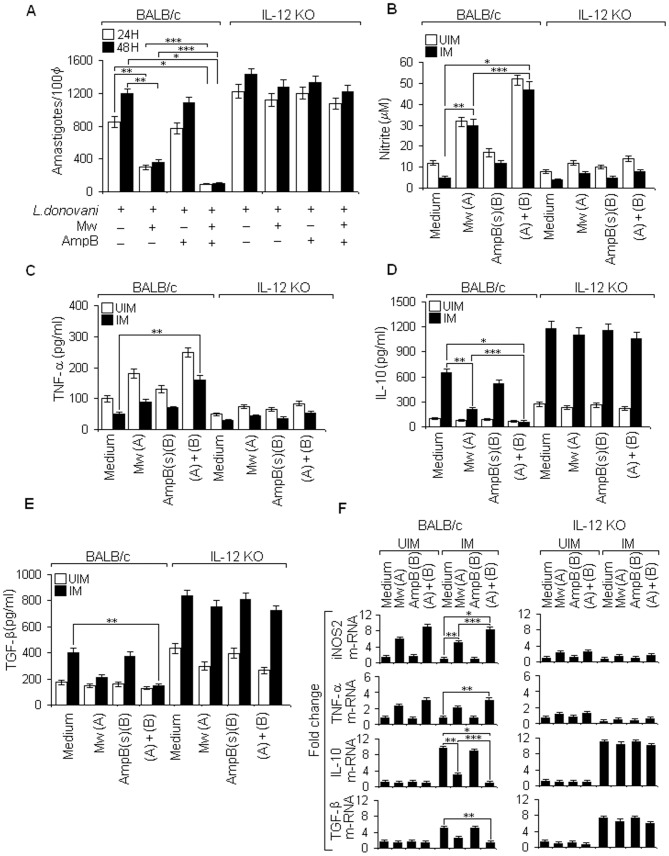
IL-12 is critical for Mw and suboptimal dose of AmpB mediated protection against Leishmania donovani infection (A–F).(A) Peritoneal macrophages, isolated from BALB/c and IL-12p40−/− mice, were cultured in eight chambered cover slides and infected with L. donovani. Infected macrophages were treated with Mw (107/ml) or Mw plus AmpB (0.1 µg/ml) for 20 h and 44 h and intracellular parasites were counted per 100 macrophages after Giemsa staining. The experiment was repeated four times, yielding similar results and data were expressed as mean ± SD. (B) Uninfected or Leishmania infected BALB/c and IL-12p40−/− peritoneal macrophages (106cells/ml) were treated with Mw (107cells/ml), AmpB (0.1 µg/ml), or Mw plus AmpB for 48 h. Cell-free supernatants were assayed for nitrite generation by Griess method as described in the Material method section. (C) Uninfected or Leishmania infected BALB/c and IL-12p40−/− peritoneal macrophages (2×106cells/ml) treated with Mw (107cells/ml), AmpB (0.1 µg/ml), or Mw plus AmpB, for 20 h. Cell-free supernatants were collected for estimation of TNF-α, TGF-β, and IL-10 by sandwich ELISA. (F) Total RNA was extracted from similarly treated uninfected or Leishmania infected BALB/c and IL-12p40−/− peritoneal macrophages using TRIZOL and Real Time -PCR was performed to study mRNA expression of different pro-inflammatory and anti-inflammatory cytokines. The experiment was repeated 3 times, yielding similar results and data were expressed as mean ± SD. *P<0.001, **P<0.01 compared with infected macrophages and ***P<0.05 compared with Mw treated macrophages; paired two-tailed Student’s t-test.